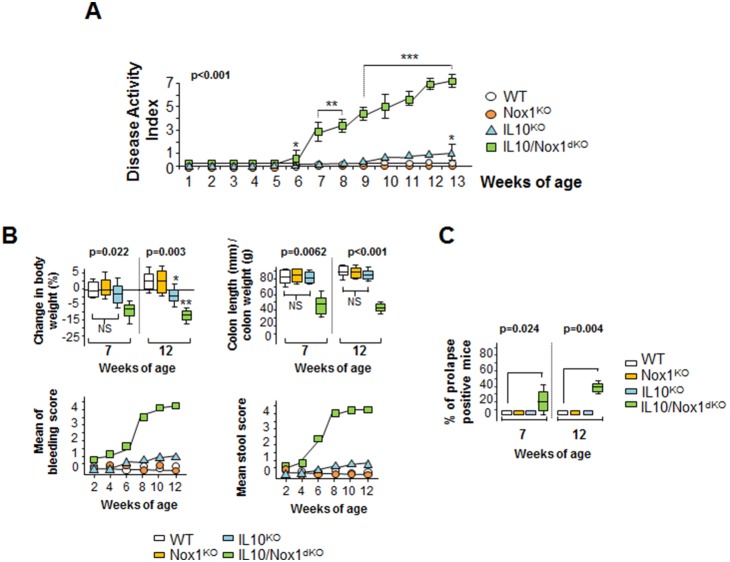
Spontaneous colitis in IL10/Nox1dKO mice.(A) The DAI is measured daily in WT (n = 10), Nox1KO (n = 10), IL10KO (n = 10), and IL10/Nox1dKO (n = 25) mice. Statistics: p-values for Kruskal-Wallis non-parametric analysis are shown, Dunn’s multiple comparison test versus WT; *p<0.05, **p<0.01, ***p<0.001. (B) Clinical symptoms of IL10/Nox1dKO mice. Body weight changes, rectal bleeding and stool scores were assessed daily. The weight-to-length ratio was determined for each individual colon of WT (n = 10), Nox1KO (n = 10), IL10KO (n = 10), and IL10/Nox1dKO (n = 25) mice aged 7 and 12 weeks. Statistics: box plots show median, quartiles, and range; p-values for Kruskal-Wallis non-parametric analysis are shown, Dunn's multiple comparison test vs. WT, NS, not significant. (C) Percentage of WT (n = 10), Nox1KO (n = 10), IL10KO (n = 20), and IL10/Nox1dKO (n = 30) mice with prolapse at 7 and 12 weeks of age. Statistics are as in (B).